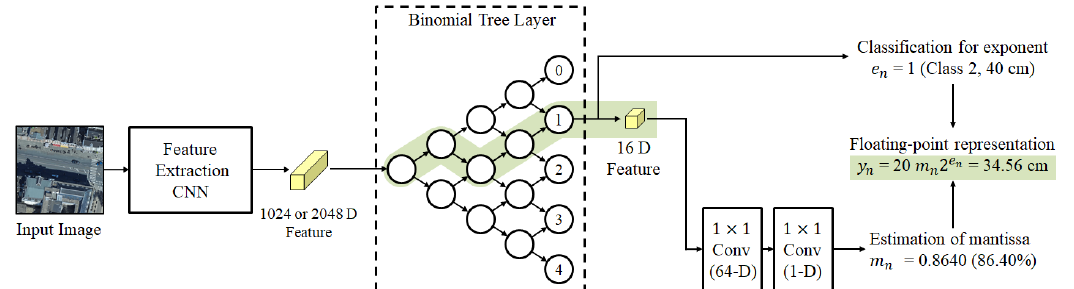
Figure 2. The architecture of the regression tree convolutional neural network (CNN), which consists of the feature extraction CNN and the binomial tree layer. For the feature extraction CNN, we use MobileNet [36] (1024-D) or ResNet [37]